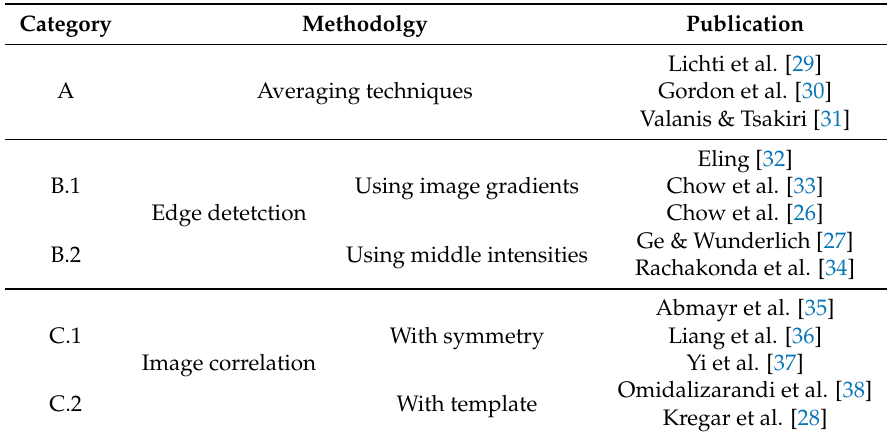
Table 1. Literature overview of algorithms for the target center estimation (TCE) categorized into three methodological